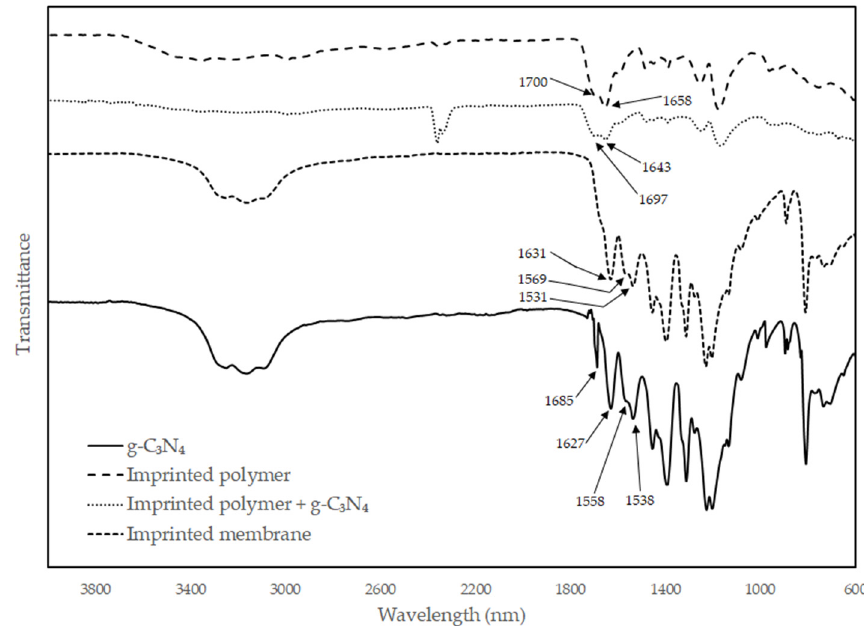
Figure 4. FT-IR for g-C 3 N 4 , imprinted adsorbent and membrane for ammonia removal.